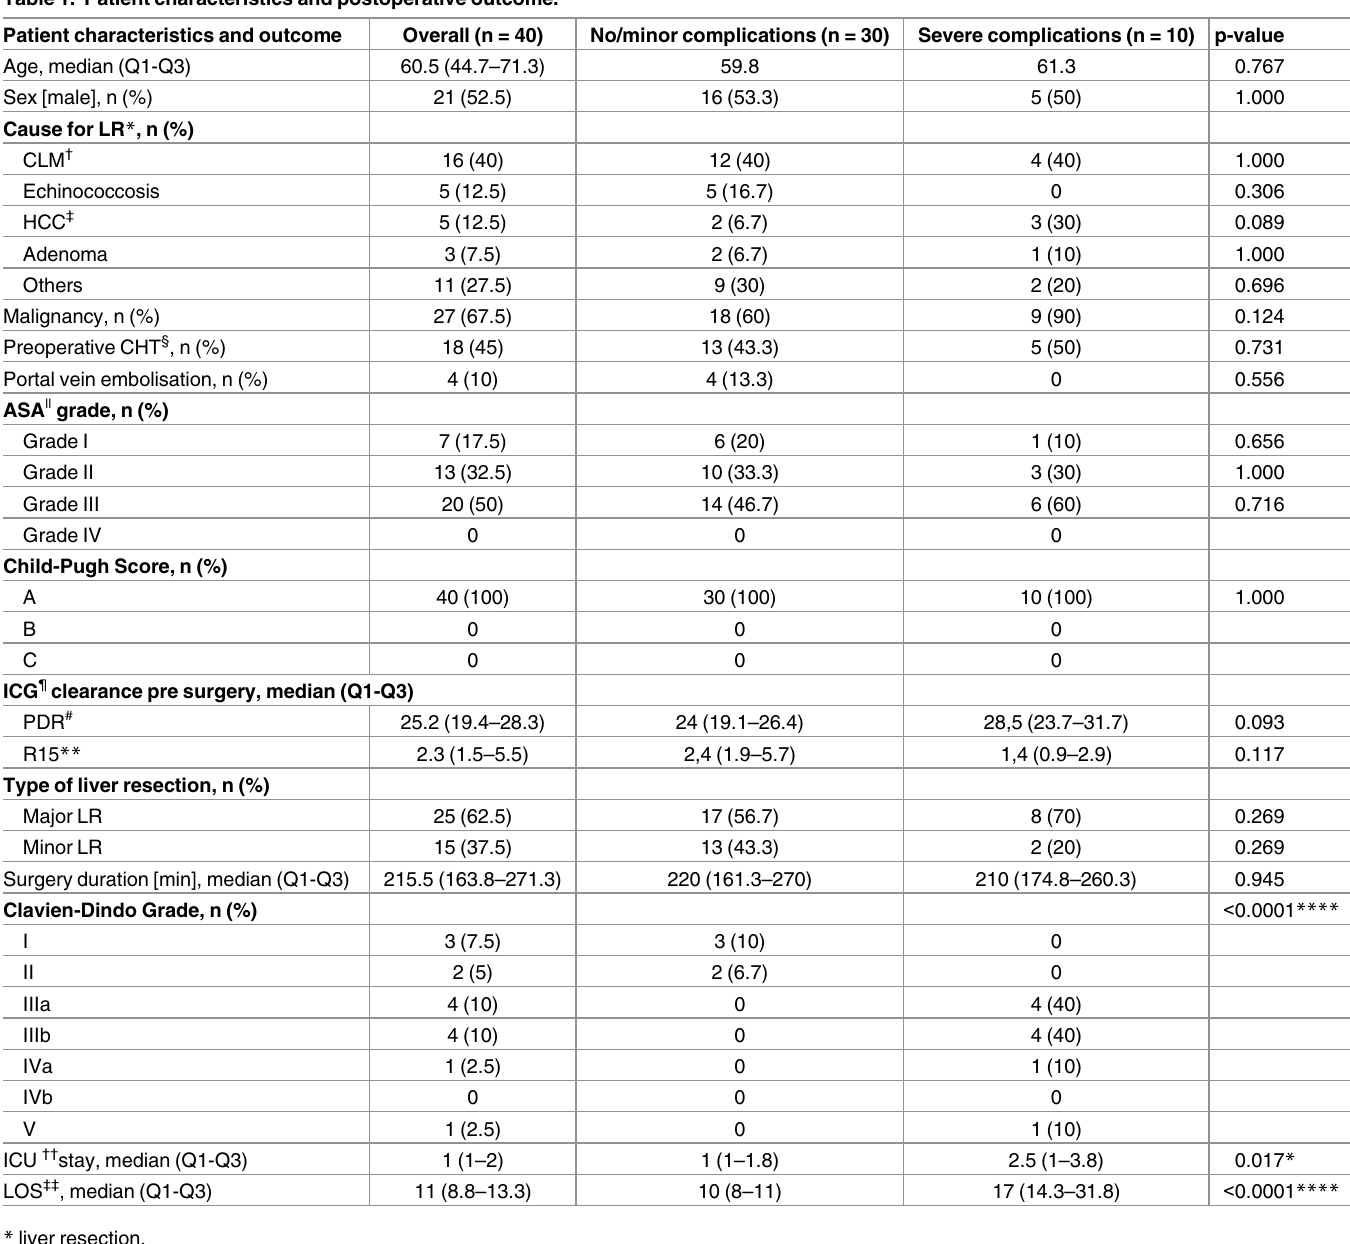
Table 1. Patient characteristics and postoperative